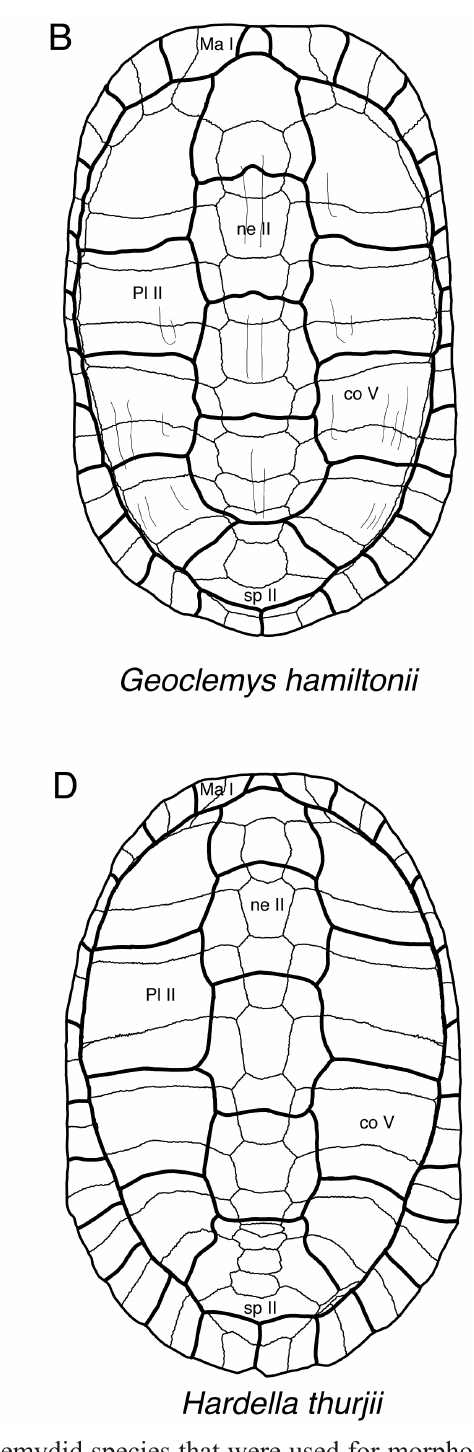
Fig. 2. Illustration of the carapace of four extant geoemydid species that were used for morphological comparison with Siwalik specimens. A . Carapace of Batagur borneoensis (Schlegel & Müller, 1845) (FMNH 251499), a geoemydid from Borneo that here illustrates the general shape of species of Batagur Gray, 1856. B . Geoclemys hamiltonii (Gray, 1830) (NMW 39986), a geoemydid from the Indian subcontinent. C . Melanochelys trijuga (Schweigger, 1812) (NMW 37159), a geoemydid from the Indian subcontinent. D . Carapace of Hardella thurjii (Gray, 1831) (FMNH 224153), a geoemydid from India and